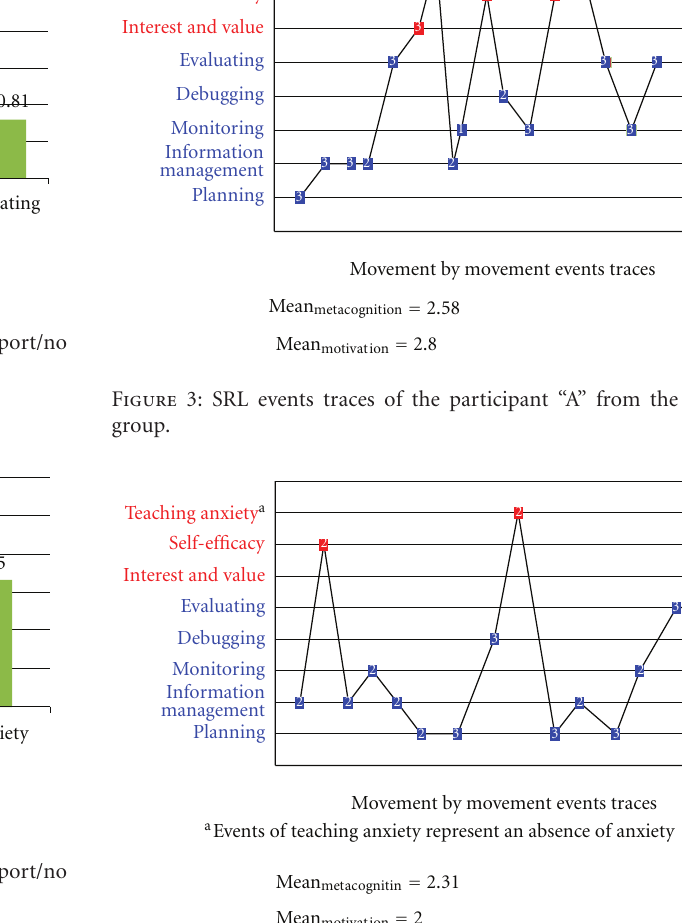
Figure 4: SRL events traces of the participant “B” from the NS